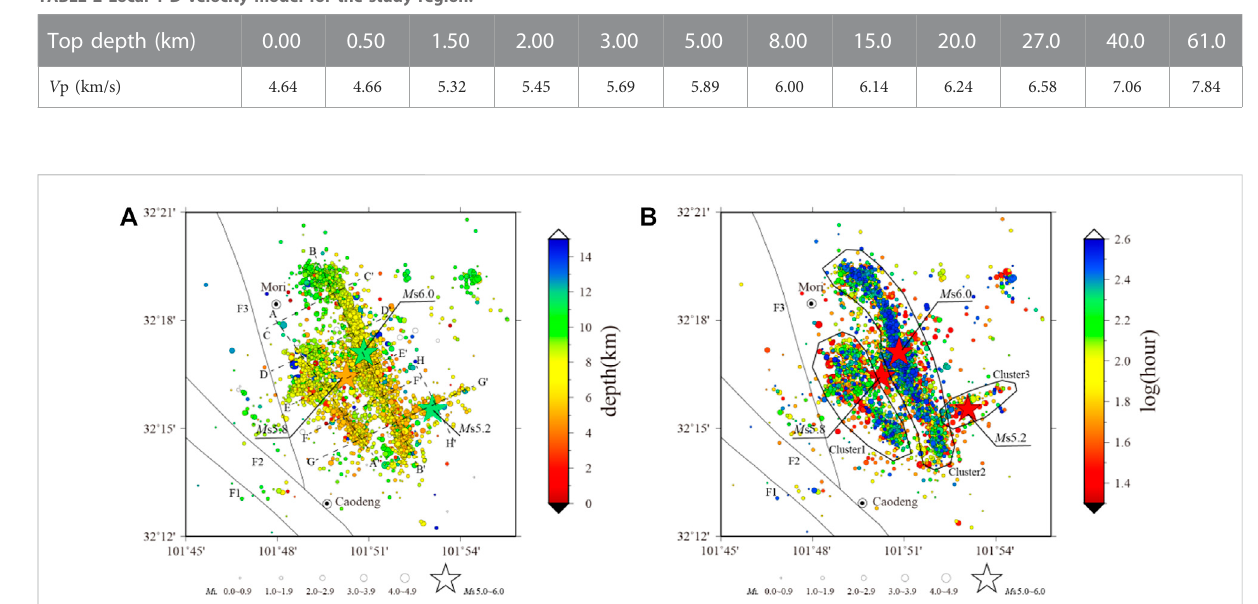
FIGURE 3 Relocated epicenters of the M s6.0 Maerkang earthquake sequence. (A) Color-coded by depth. Dashed lines indicate the positions of the pro fi les, which areshown inFigures 4,8. (B) Color-coded byoccurrencetime. Blackpolygonsdenotethethreeearthquakeclustersdiscussedinthe text. F1 – F3: branches of the Songgang fault.